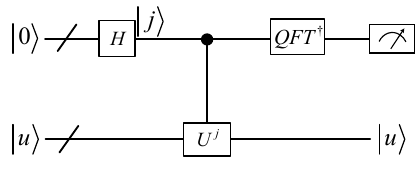
Figure 1. A c ircuit for phase estimation. Figure 1. A circuit for phase